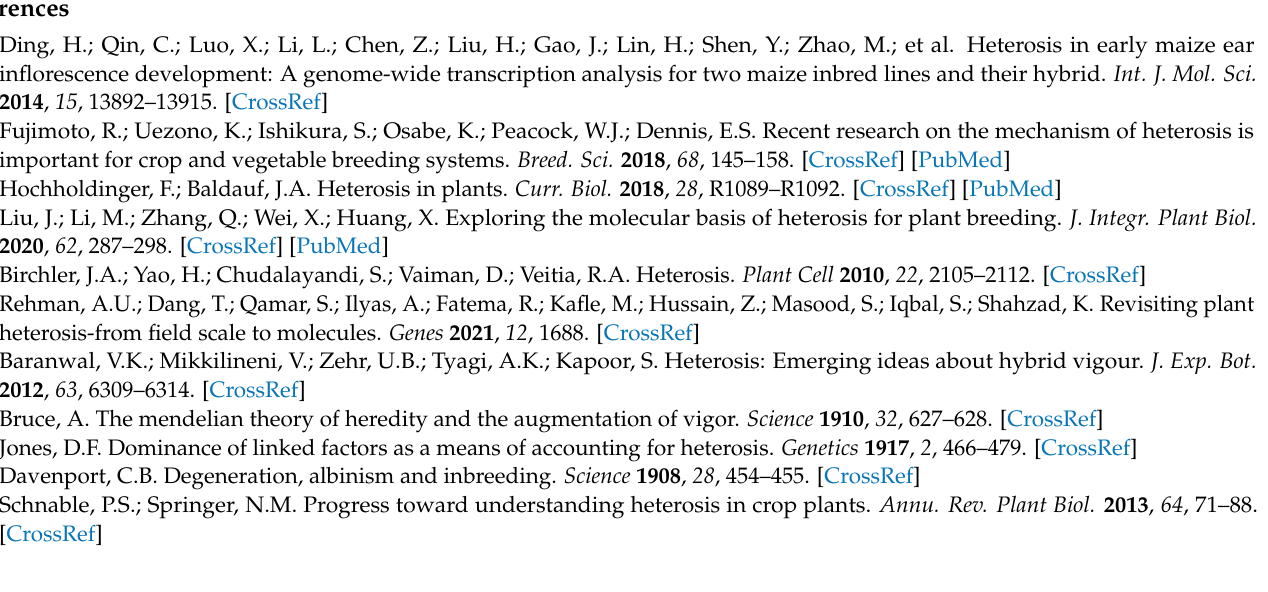
Table S4: Go term classification table of differential expression genes in different cross combinations, Table S5: KEGG enrichment analysis of differential expression genes in different cross combinations, Table S6: KEGG Enrichment analysis of module genes in hybrids of Chinese